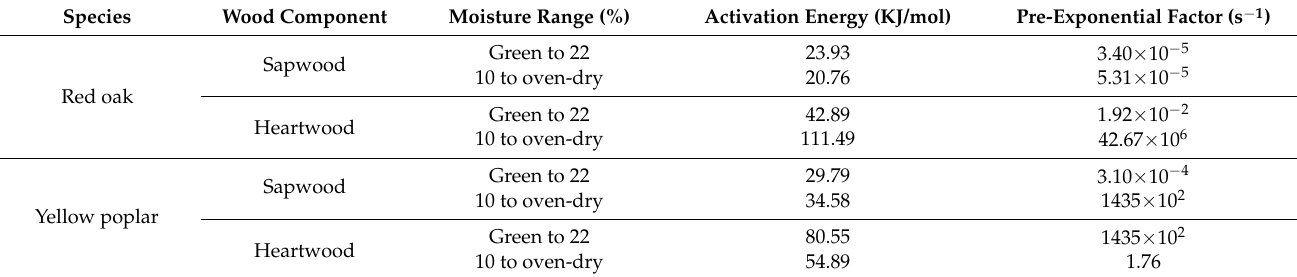
Table 5. Activation energy and pre-exponential